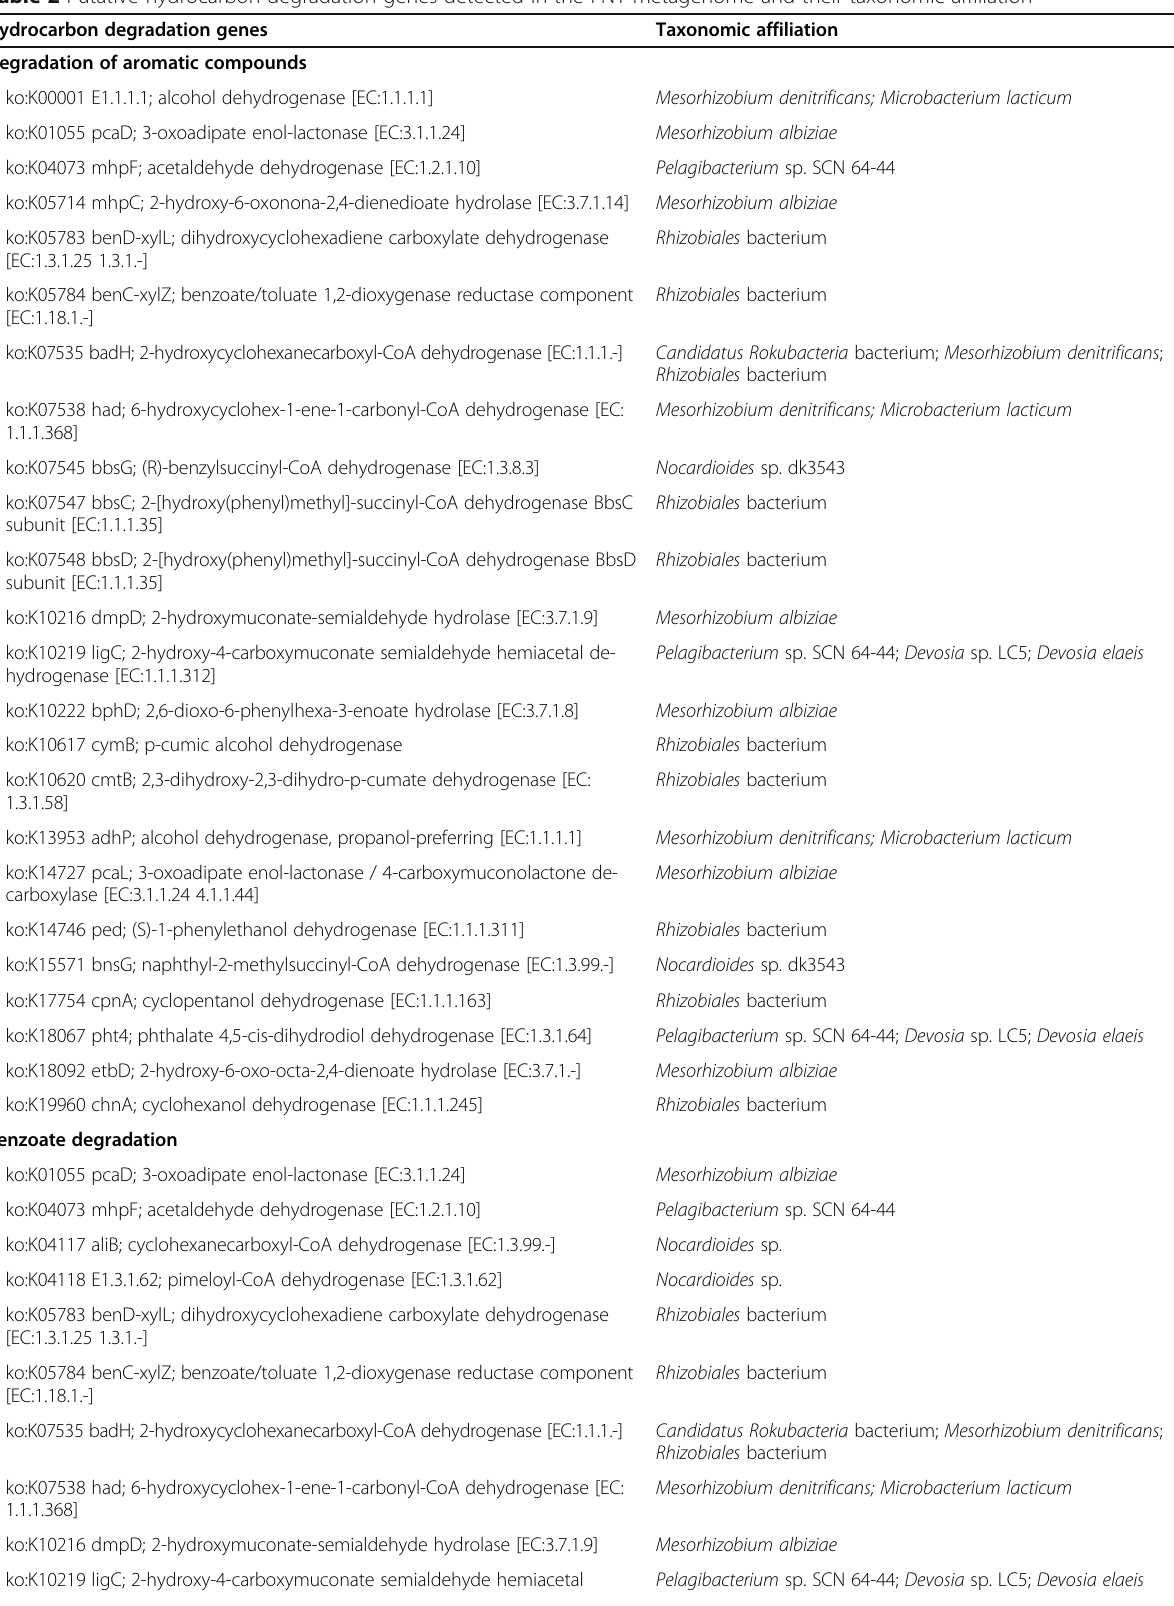
Table 2 Putative hydrocarbon degradation genes detected in the FN1 metagenome and their taxonomic